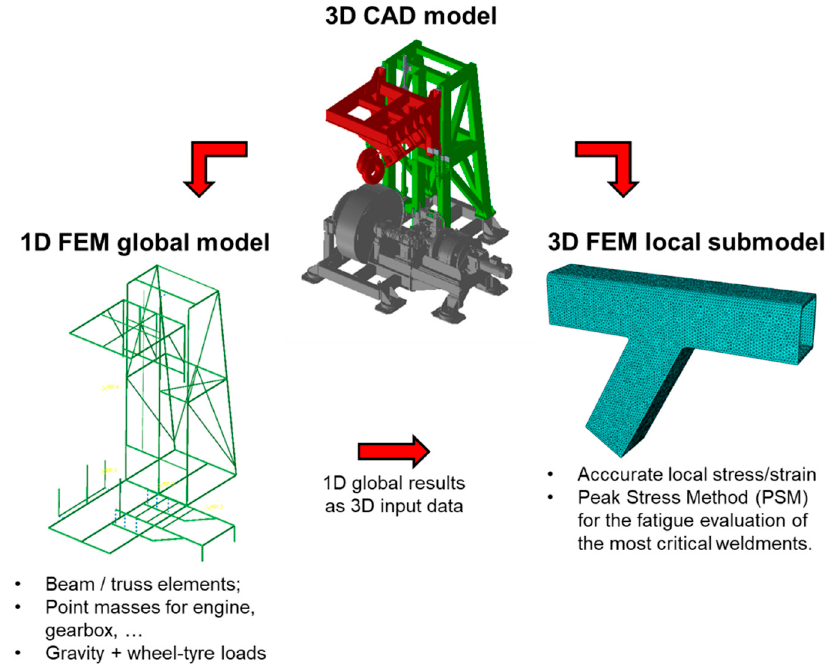
Figure 2. Overall simulation plan.